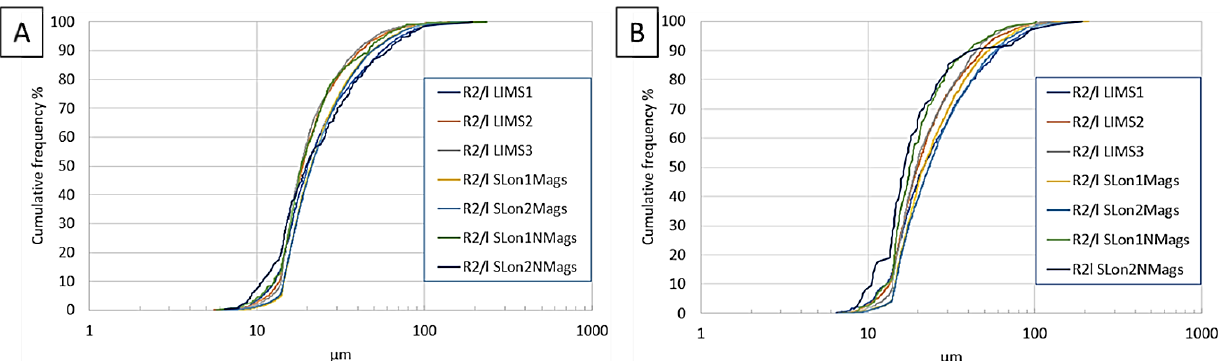
Figure 5. ( A ) Amphibole and ( B ) clinopyroxene grain size cumulative frequency% in R2/l magnetic concentrates (LIMS Mags and SLon Mags) with corresponding tailings (SLon